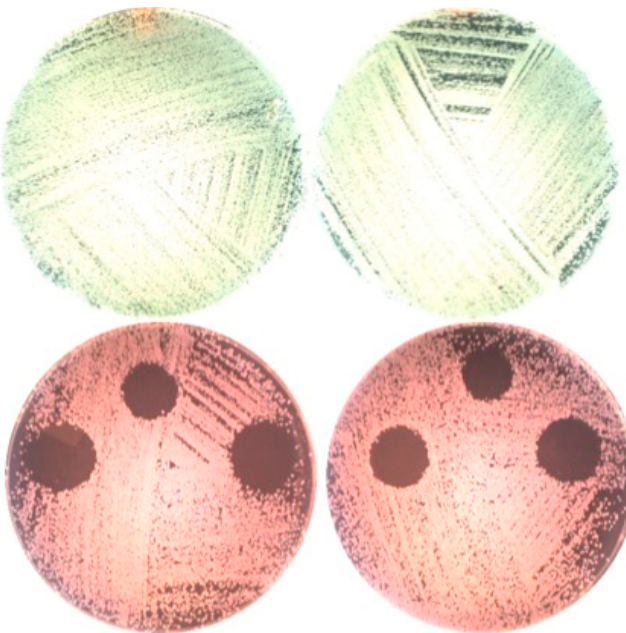
Figure 4. Plates without (upper part) and with (lower part) erythrosine after irradiation with the 532 nm green diode laser and incubation for one day.